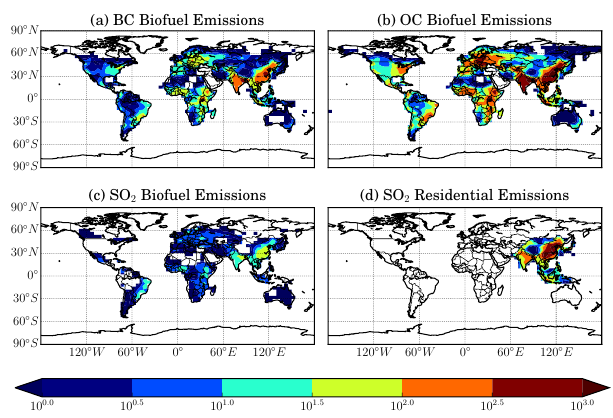
Figure 1. Annual emissions of (a) biofuel black carbon (BC) and (b) organic carbon (OC) emissions [µgCm − 2 day − 1 ] from Bond et al. (2007), (c) biofuel sulfur dioxide (SO 2 ) emissions [µgSm − 2 day − 1 ] from EDGAR, and (d) residential SO 2 over Asia (in µgSm − 2 day − 1 ) from the Street